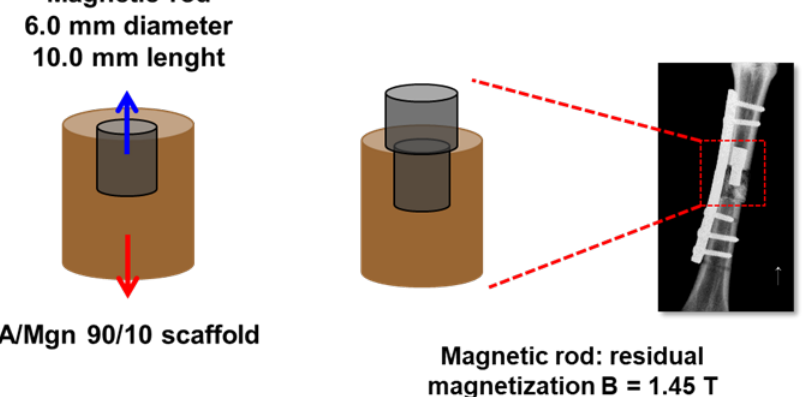
Figure 7. Schematic representation of the magnetic scaffold, fixed additionally with two permanent magnetic rods implanted in the critical size bone defect in vivo, and the radiographic image of the metatarsus with the positioning of the scaffold.